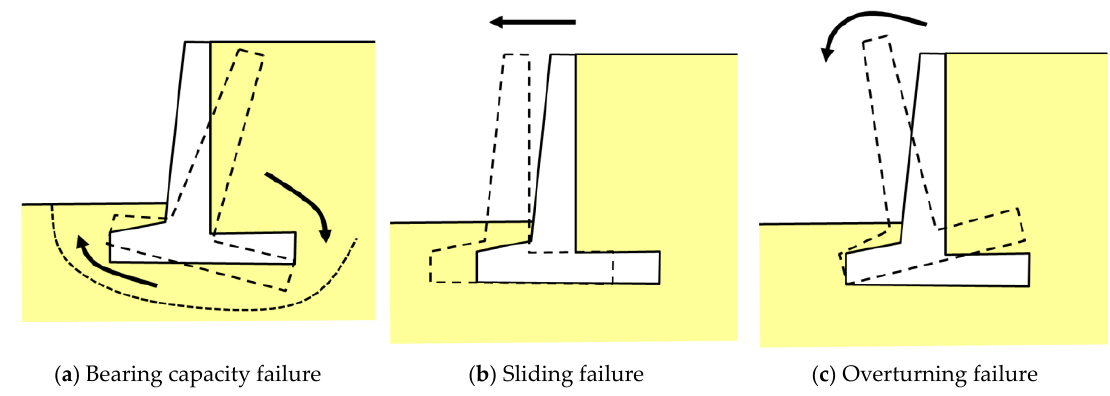
Figure 1. Stability checks for reinforced concrete retaining walls.